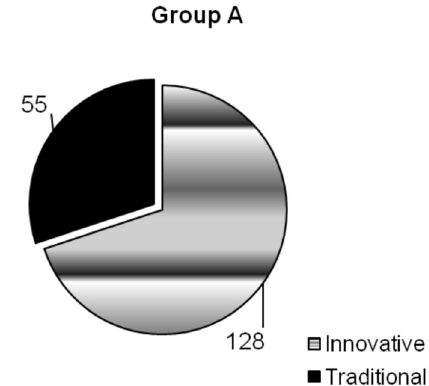
FIGURE 3 - Total entries in Group A.